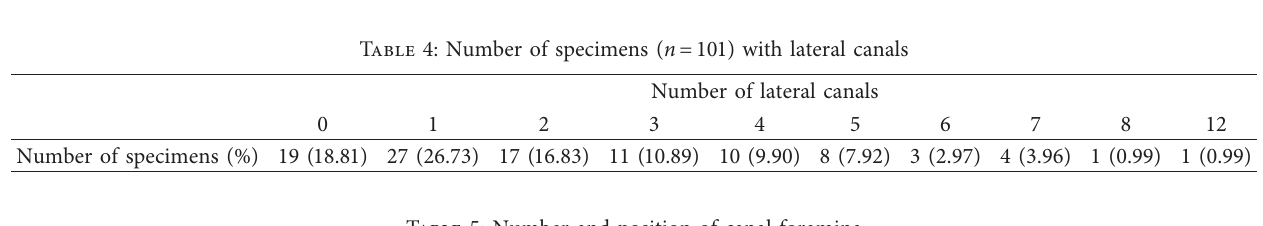
Table 5: Number and position of canal